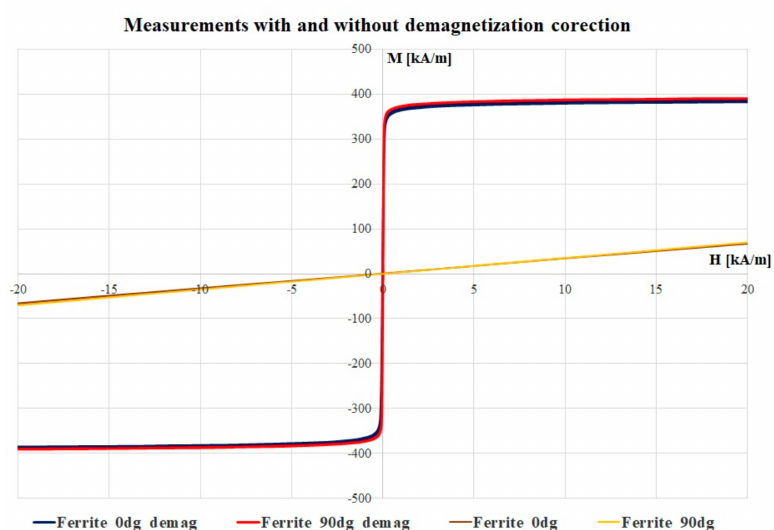
Figure 6. Comparison between the hysteresis loops with and without the applied magnetization factor, considering only the low magnetic field